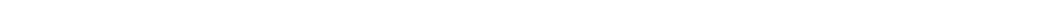
(see fi gure on previous page) Fig. 1 Cryo-EM structure of L 8 F 8 X 16 . a The overall structure of L 8 F 8 X 16 is shown in two orientations rotated by 90°. The RbcL octameric core is shown as the surface, with the two subunits of each dimer colored in pink and blue, respectively. The four Raf1 α dimers and the eight RbcX dimers are shown as cartoons. The two subunits of each Raf1 α dimer are respectively colored in marine and magenta, whereas those of each RbcX dimer are respectively colored in yellow and green. The interfaces between RbcL – Raf1 α , RbcL – RbcX, and Raf1 α – RbcX are indicated by dashed boxes. b – d The three interfaces of RbcL – Raf1 α ( b ), RbcL – RbcX ( c ), and RbcX – Raf1 α ( d ) in L 8 F 8 X 16 . The color scheme of each subunit is the same as that in the overall structure of L 8 F 8 X 16 . RbcL, Raf1 α , and RbcX are shown as semi-transparent cartoons. The interacting residues are shown as sticks and labeled, with hydrogen bonds indicated as dashed lines. e Structural comparison of two RbcX dimers in the structures of L 8 F 8 X 16 and L 8 X 16 (PDB, 3RG6). f Structural comparison of Raf1 α domains in the structures of L 8 F 8 X 16 and L 8 F 8 (PDB,